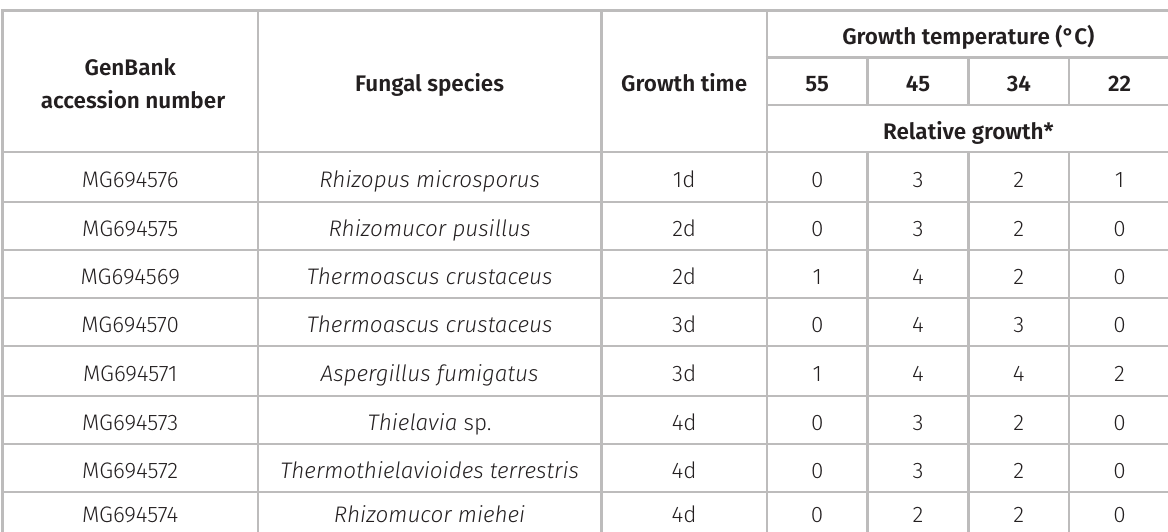
Table II. Temperature dependence growth of Araucaria Forest thermophilic fungal